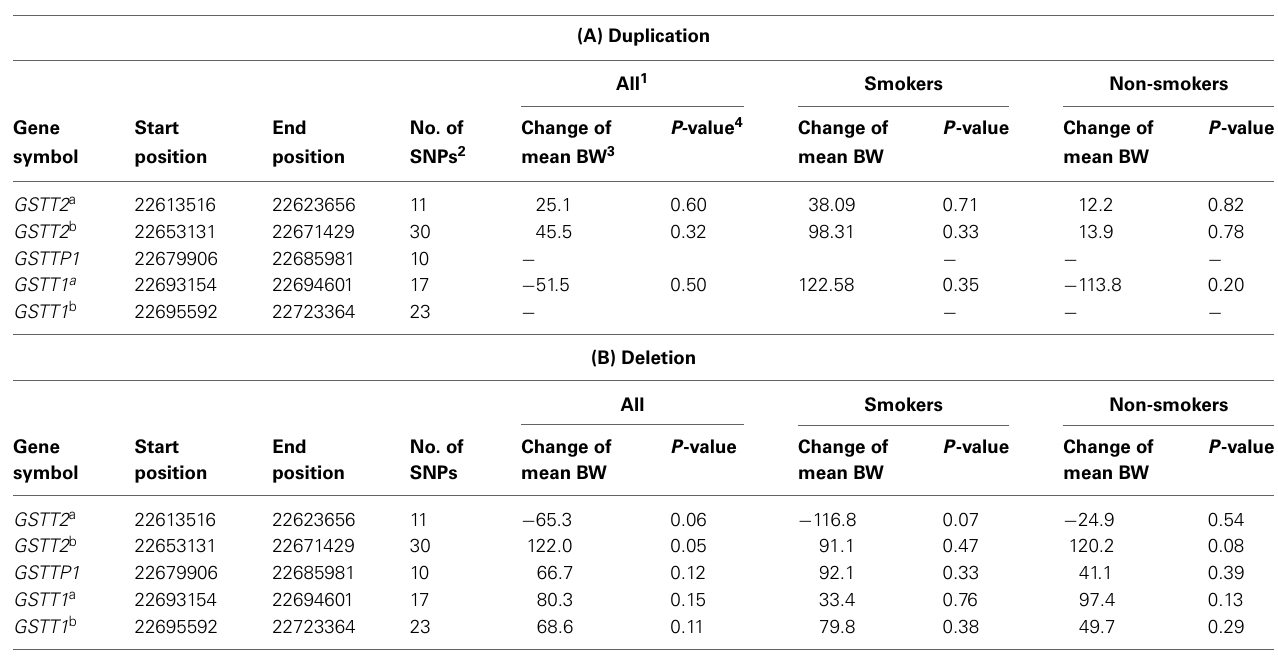
Table 3 | Effect of CNVs in GSTT1/GSTT2 region on birth weight in full term birth mothers ∧ .